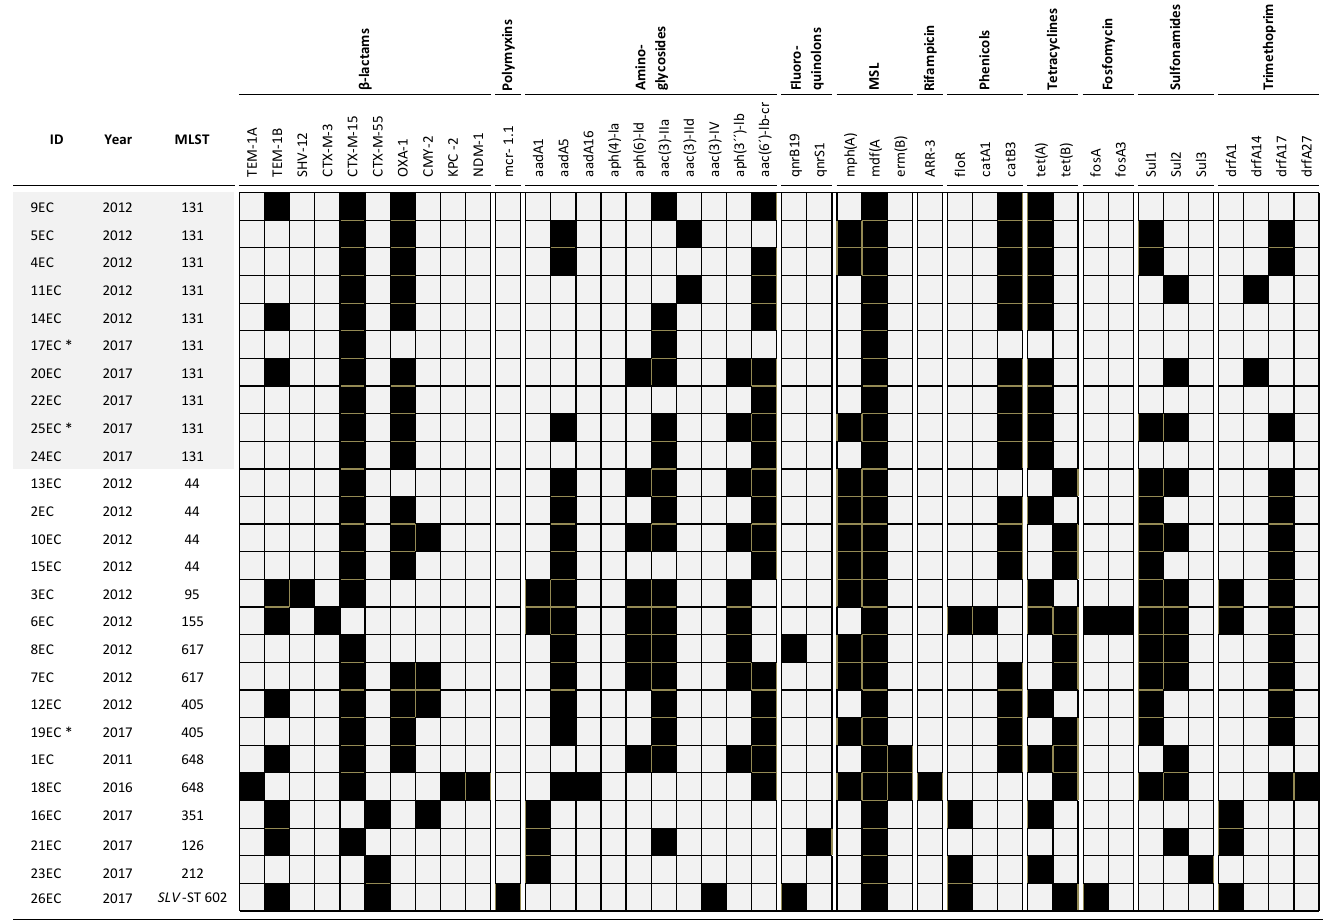
Figure 1. Antibiotic resistance genes found in the CTX-M Escherichia coli strains. Black squares represent the presence of the respective antibiotic resistance gene, and grey represents its absence. (*) Isolates recovered from blood samples. MLST: Multilocus Sequence Typing.